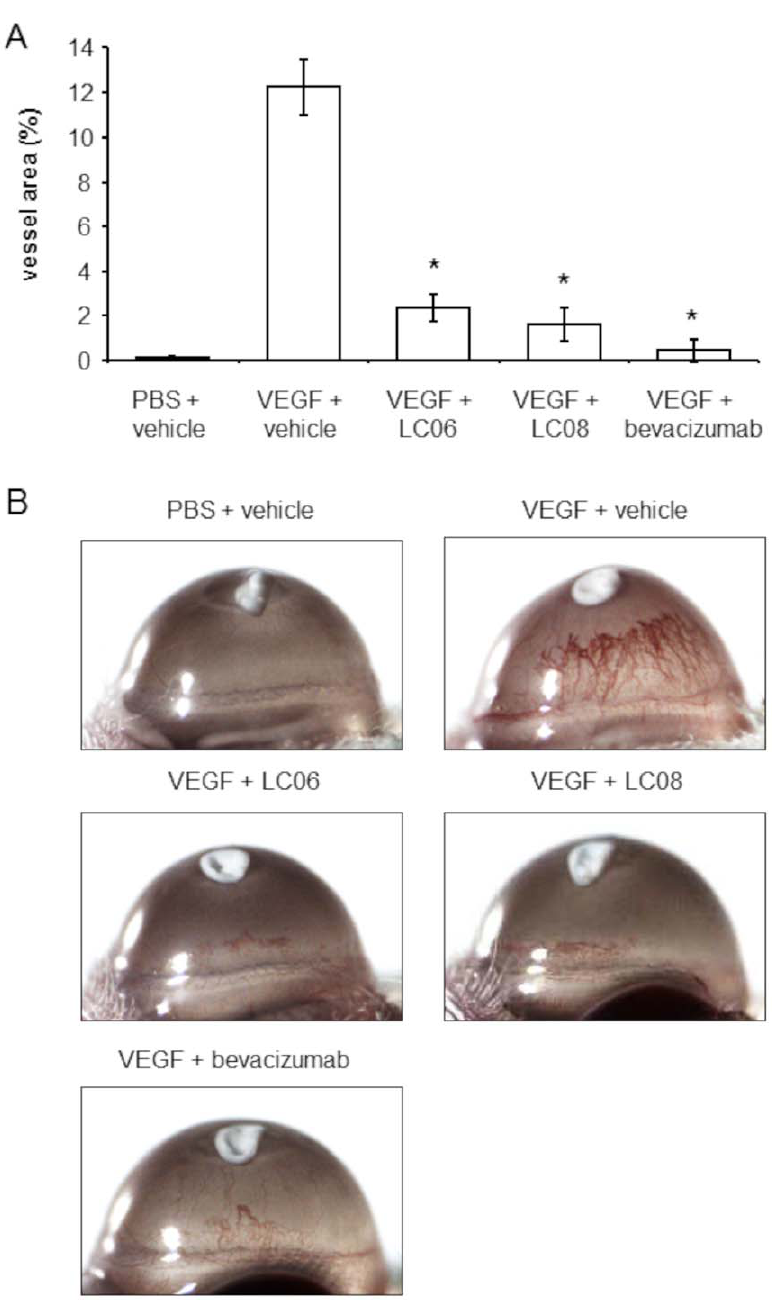
Figure 6. Effect of LC06 and LC08 treatment on VEGF-induced corneal angiogenesis. ( A ) Angiogenesis was induced by implanting VEGF (300 ng) or vehicle soaked nylaflo discs into the cornea of BALB/c mice. PBS control did not induce vessel outgrowth from the limbus to the disc compared to VEGF positive control. LC06, LC08 and bevacizumab were injected with 10 mg/kg i.v. at the day of disc implantation. Treatment with both anti-Ang-2 antibodies significantly inhibited neoangiogenesis in a comparable range as bevacizumab (n=5, *p , 0.001 compared to VEGF control, Student’s t-test). ( B ) Representative pictures of vehicle, LC06 and LC08 treated mice. The results were confirmed in 3 additional independent experiments. Results are expressed as mean 6 SEM. 2 selective and does not interfere with the Tie2-Ang-1 interaction, (Figure S1). The SPR data summarized in Figure S2B and Table S1 confirm similar single digit 1 nM affinity of LC06 and whereas LC08 recognizes Ang-1 with significant affinity and LC08 for human Ang-2 and a more than 1000-fold reduced affinity of LC06 for human Ang-2, whereas LC08 binds Ang-1 with ca. 10-fold lower 12 nM affinity. The results were confirmed in 2 independent experiments.